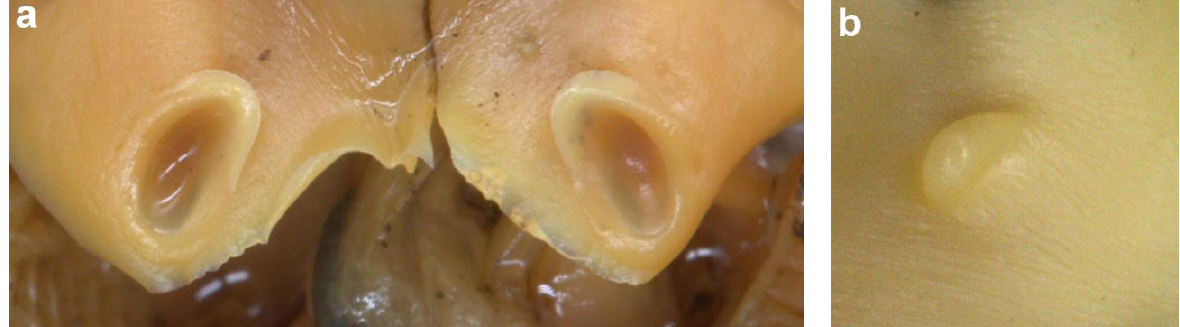
Figure 20. Sepia typica (SAIAB 211627, male ML 18 mm) funnel/mantle locking mechanism; ( a ) Funnel component; ( b ) Mantle component.